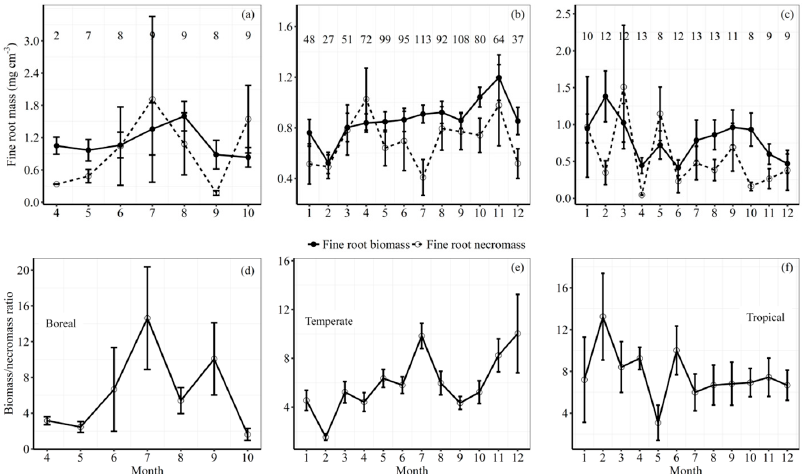
Figure 2. Monthly variation of fine root biomass, necromass and their biomass / necromass ratio for boreal ( a , d ), temperate ( b , e ) and tropical forests ( c , f ). Values were expressed as mean ± 1 standard error. The numbers indicate the sample size.